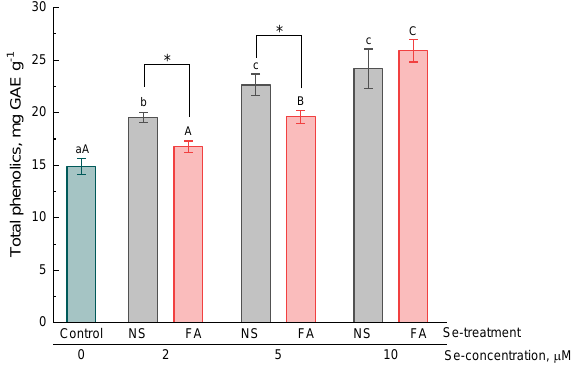
Figure 5. Effect of type and concentration of Se application on the total phenolic compound content in basil leaves.